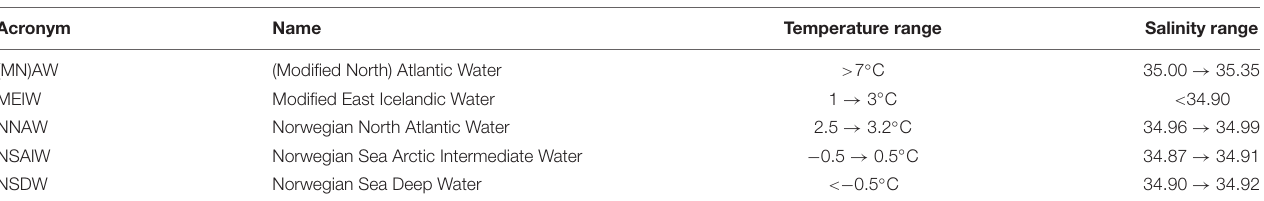
FIGURE 1 | Overview over the study region. The counterclockwise circulating Norwegian Sea Gyre (NSG) and the subpolar gyre (SPG) – composed of cold and dense subarctic waters – are highlighted in blue color. The NSG rim is outlined in yellow color and the IFR-North region is illustrated in gray. Poleward flowing AW are shown in red. The location of monitoring Section N is illustrated with a black line. FBC, Faroe Bank Channel; IFR, Iceland-Faroe Ridge; FSC, Faroe-Shetland Channel; FSCJ, Faroe-Shetland Channel Jet; IFSJ, Iceland-Faroe Slope Jet; FC, Faroe Current; and EIC, East Icelandic Current. The following depth contours are plotted: 200, 500, 1000, 2000 (heavy contour line), and 3000 m. TABLE 2 | List of water mass